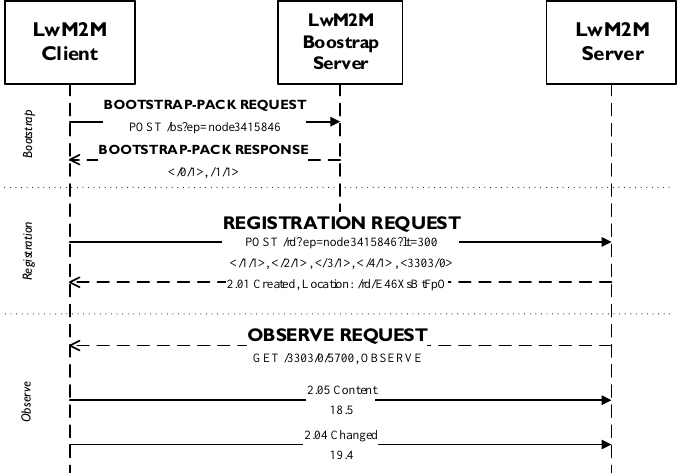
Figure 17. LwM2M bootstrap, registration, and observe